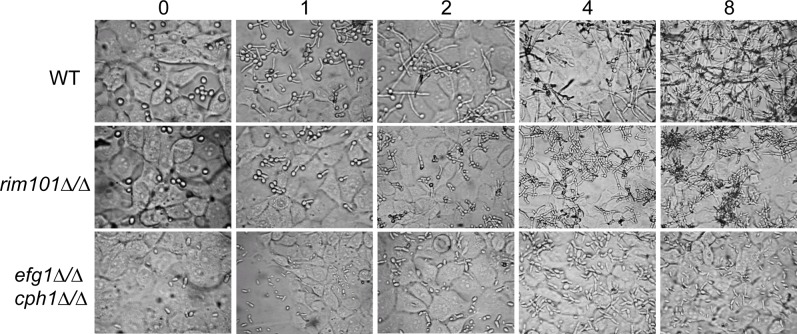
Growth of C. albicans on epithelial cells.Wild-type, rim101Δ/Δ, and efg1 cph1Δ/Δ strains were co-cultured with FaDu epithelial cell monolayers at 37°C in a 5% CO2 incubator. At the indicated times post-infection cells were photographed.